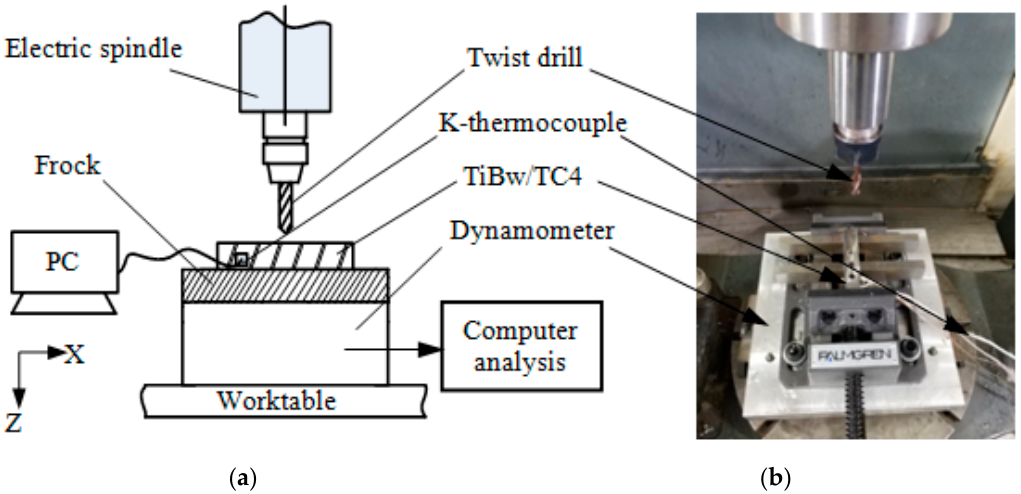
Figure 3. Drilling experiments on TiBw/TC4 composite. ( a ) Schematic diagram of drilling procedure; and ( b ) experimental setup.